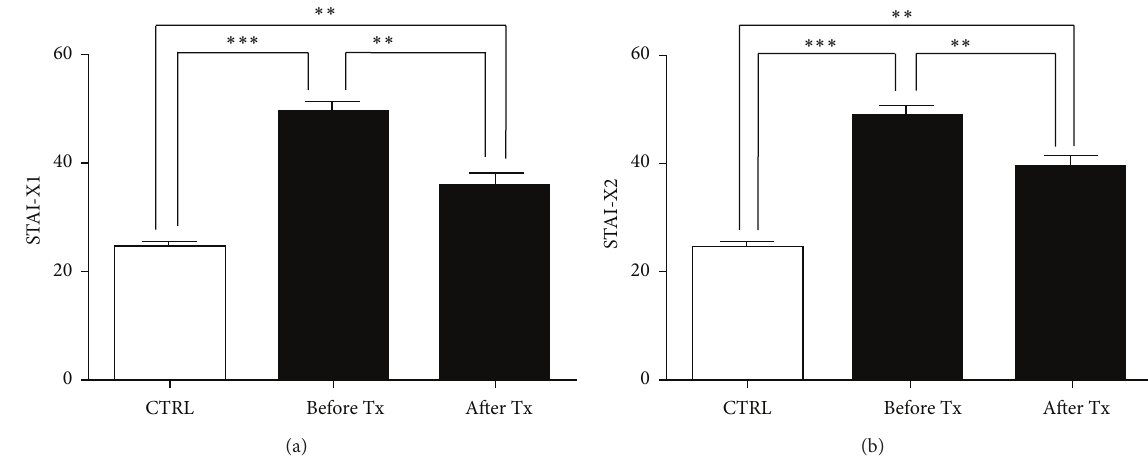
Figure 5: State anxiety (Stai-Xl) and trait anxiety (Stai-X2) questionnaire score changes after 8-week period treatment. Before Tx = before active treatment. Post Tx = after active treatment. CTRL =